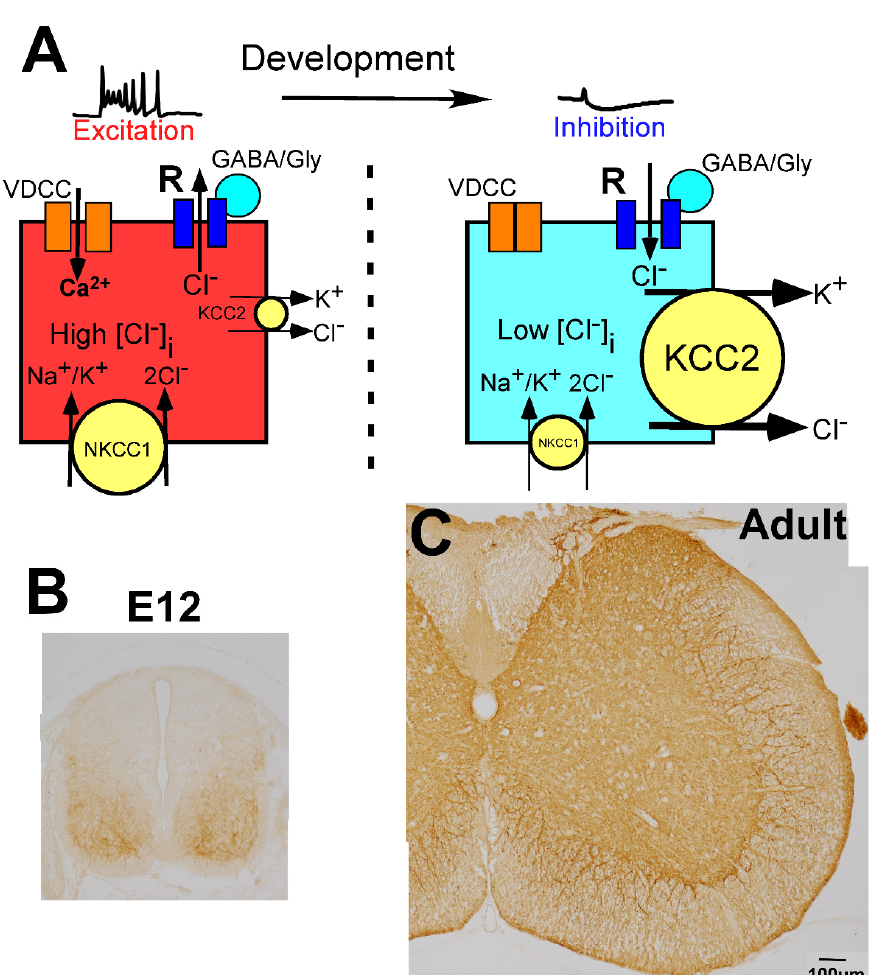
Figure 2. Molecular mechanisms underlying developmental changes in the action of GABA and glycine. ( A ) Schematic illustration of GABA action depending on intracellular Cl −